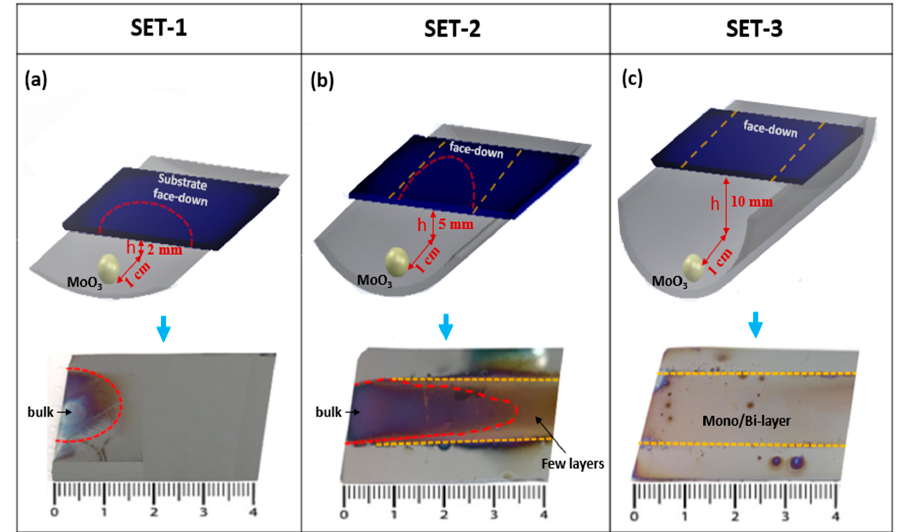
Figure 5. (Top) Schematic illustration of the vertical gap between the MoO 3 source and the face-down substrate in the quartz crucible: ( a ) 2 mm (Set-1), ( b ) 5 mm (Set-2), and ( c ) 10 mm (Set-3) along with (Bottom) supporting images of MoS 2 grown on Si/SiO 2 substrates.